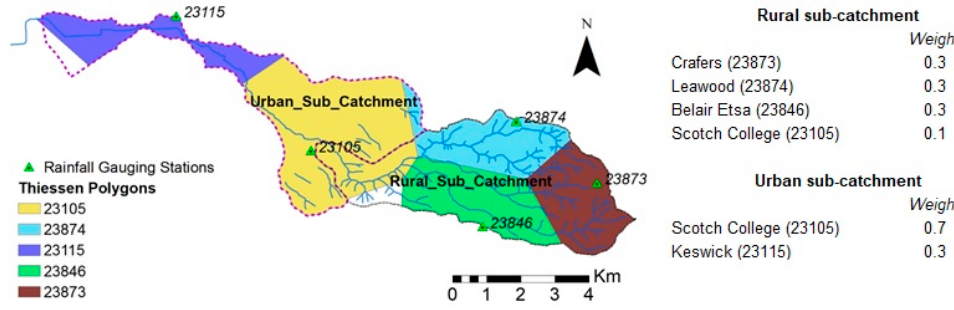
Figure 4. Thiessen polygon area and weights for the BHC catchment .